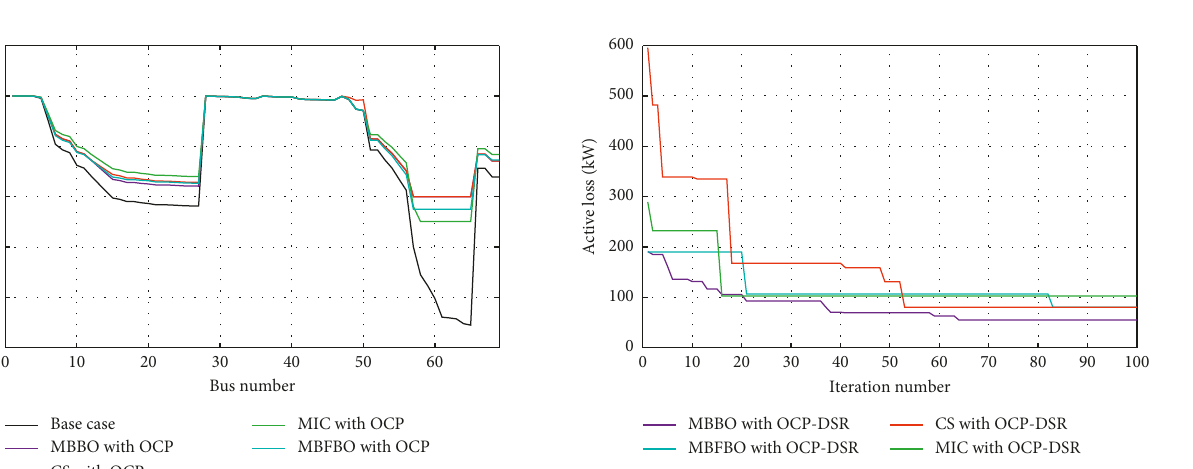
Figure 10: Convergence loss graph for 69-bus RDS using OCP- DSR technique.